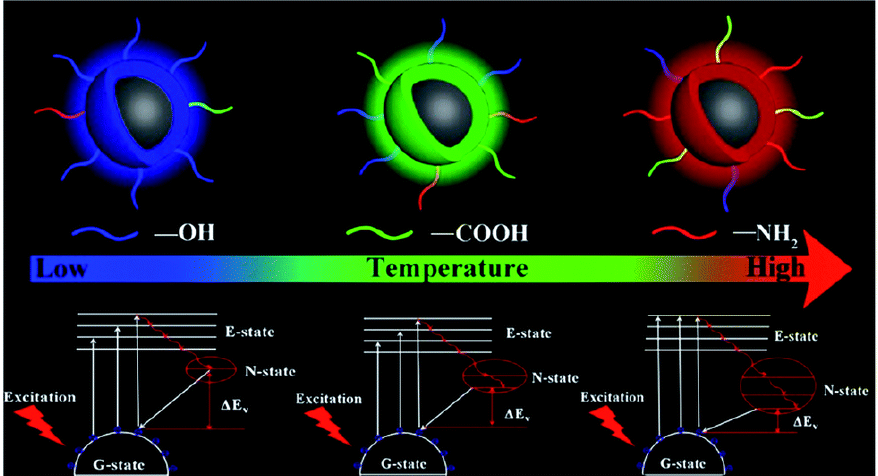
Figure 12. Schematic diagram of the luminescent and controllable synthesis mechanism. (Reproduc- tion from [117]; with the permission of the Royal Society of Chemistry).